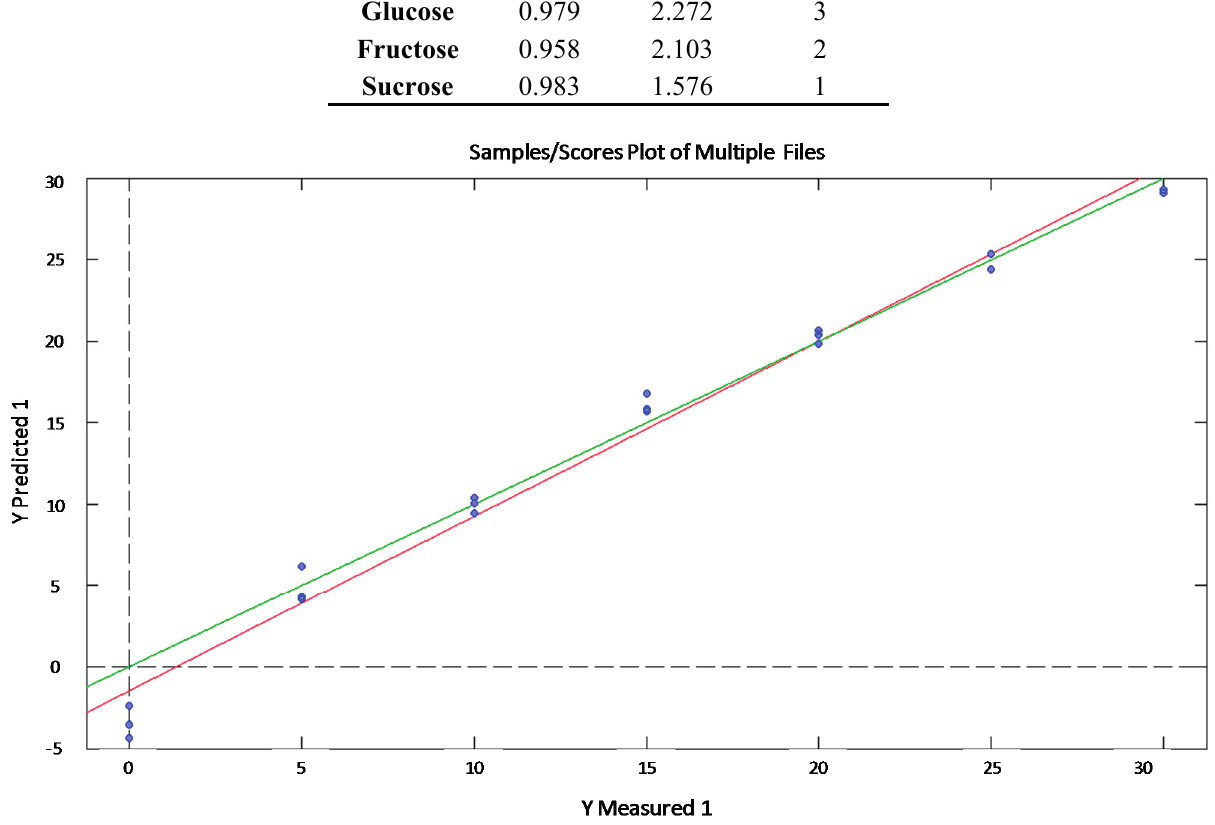
Figure 5. Correlation plot between experimental and predicted values of sucrose (g/L) by PLS statistical model (red line) and ideal behavior (green